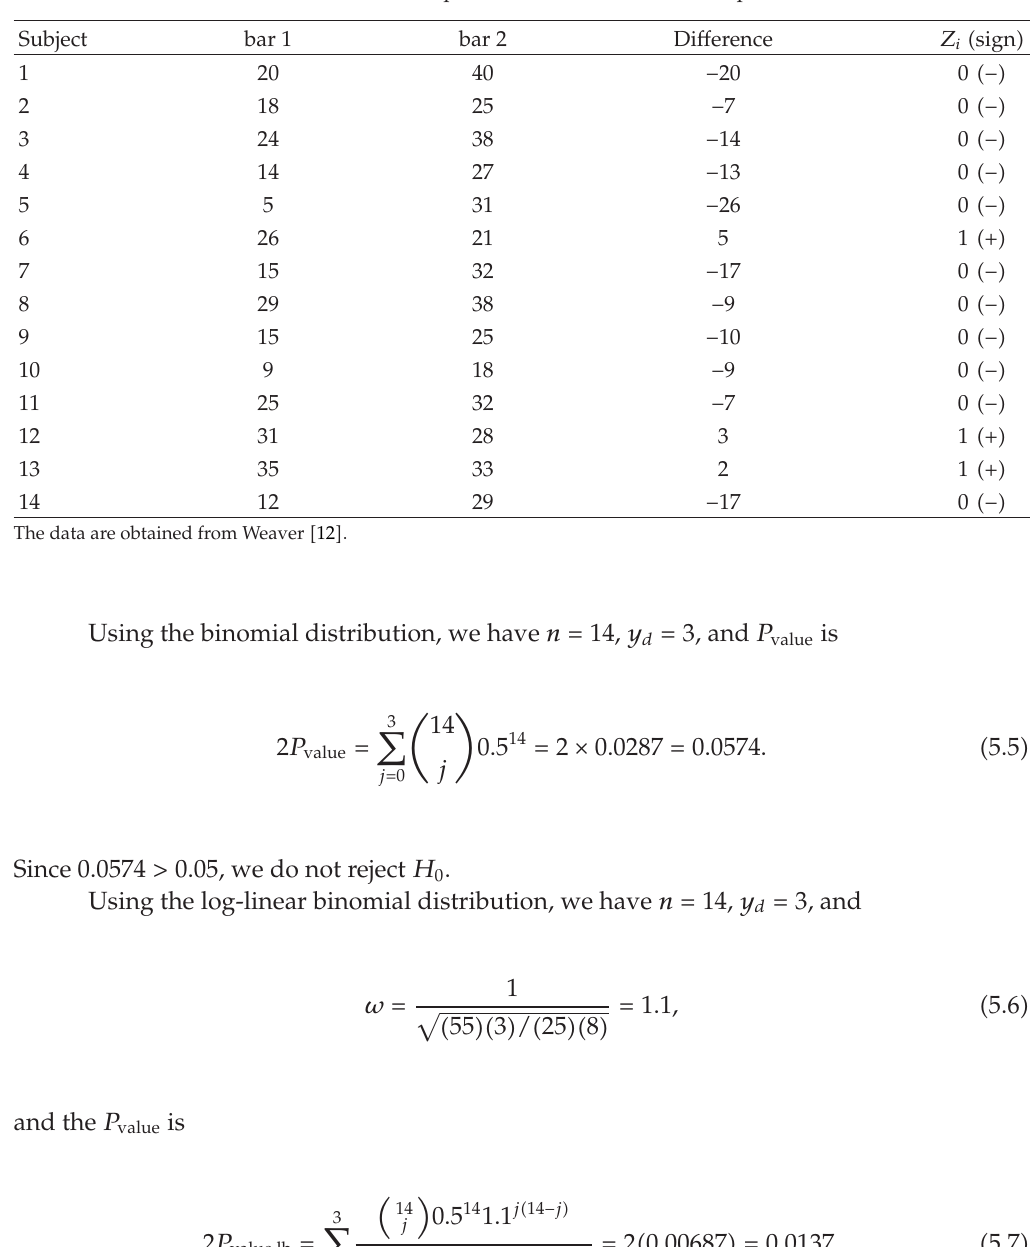
Table 1: Number of bar presses in brain stimulation